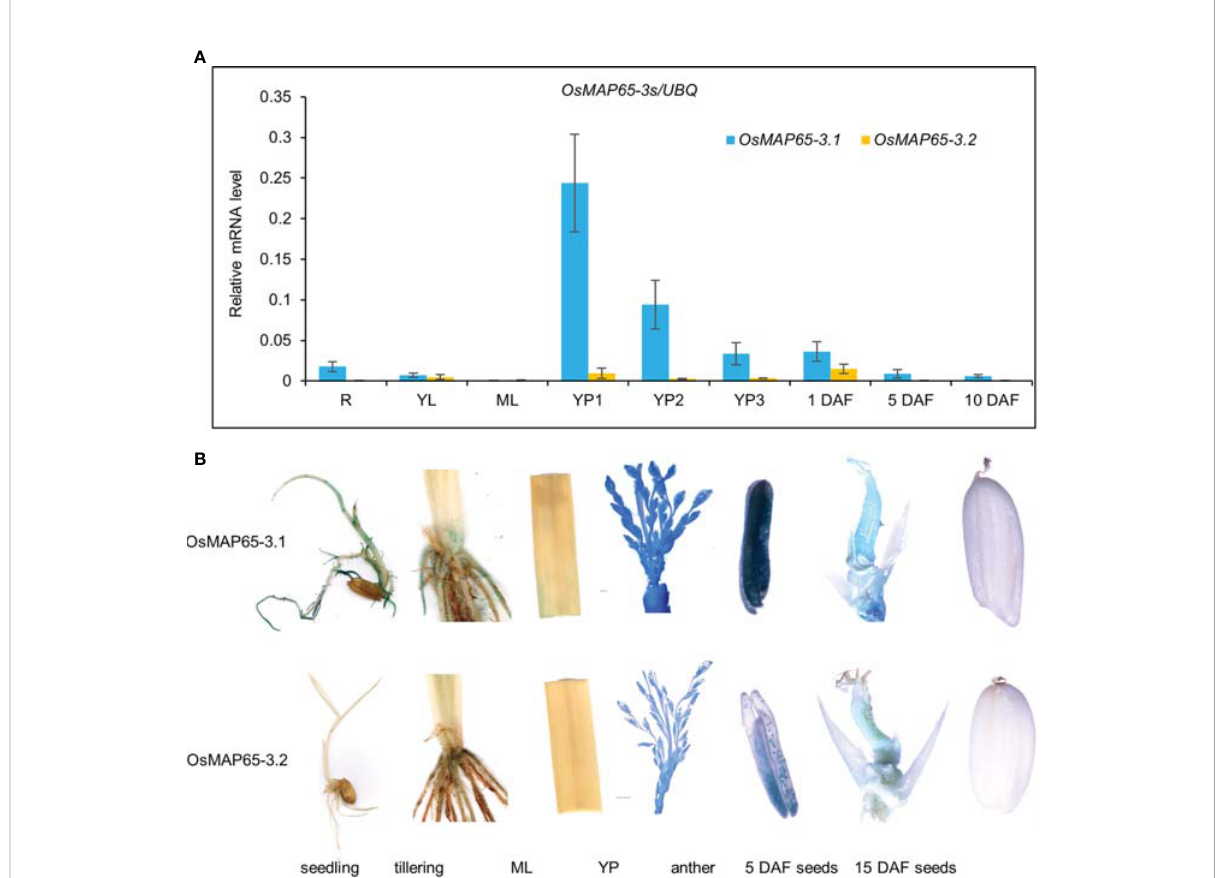
FIGURE 3 Expression patterns of OsMAP65-3.1 and OsMAP65-3.2 in rice. (A) Transcriptional levels of OsMAP65-3.1 and OsMAP65-3.2 in various tissues, including the roots (R), young leaves (YL), mature leaves (ML), YP1 – 3 (young in fl orescences < 2 cm, 2 – 5 cm, > 5 cm), 1 DAF spikelets (1day after fertilization), 5 DAF and 10 DAF seeds. The data presented are the means ± SDs of three biological replicates. (B) GUS staining of transgenic rice plants harboring p OsMAP65-3s :: GUS . The detected tissues included seedlings, tillering sites, mature leaves, young panicles, anthers, 5 DAF and 10 DAF